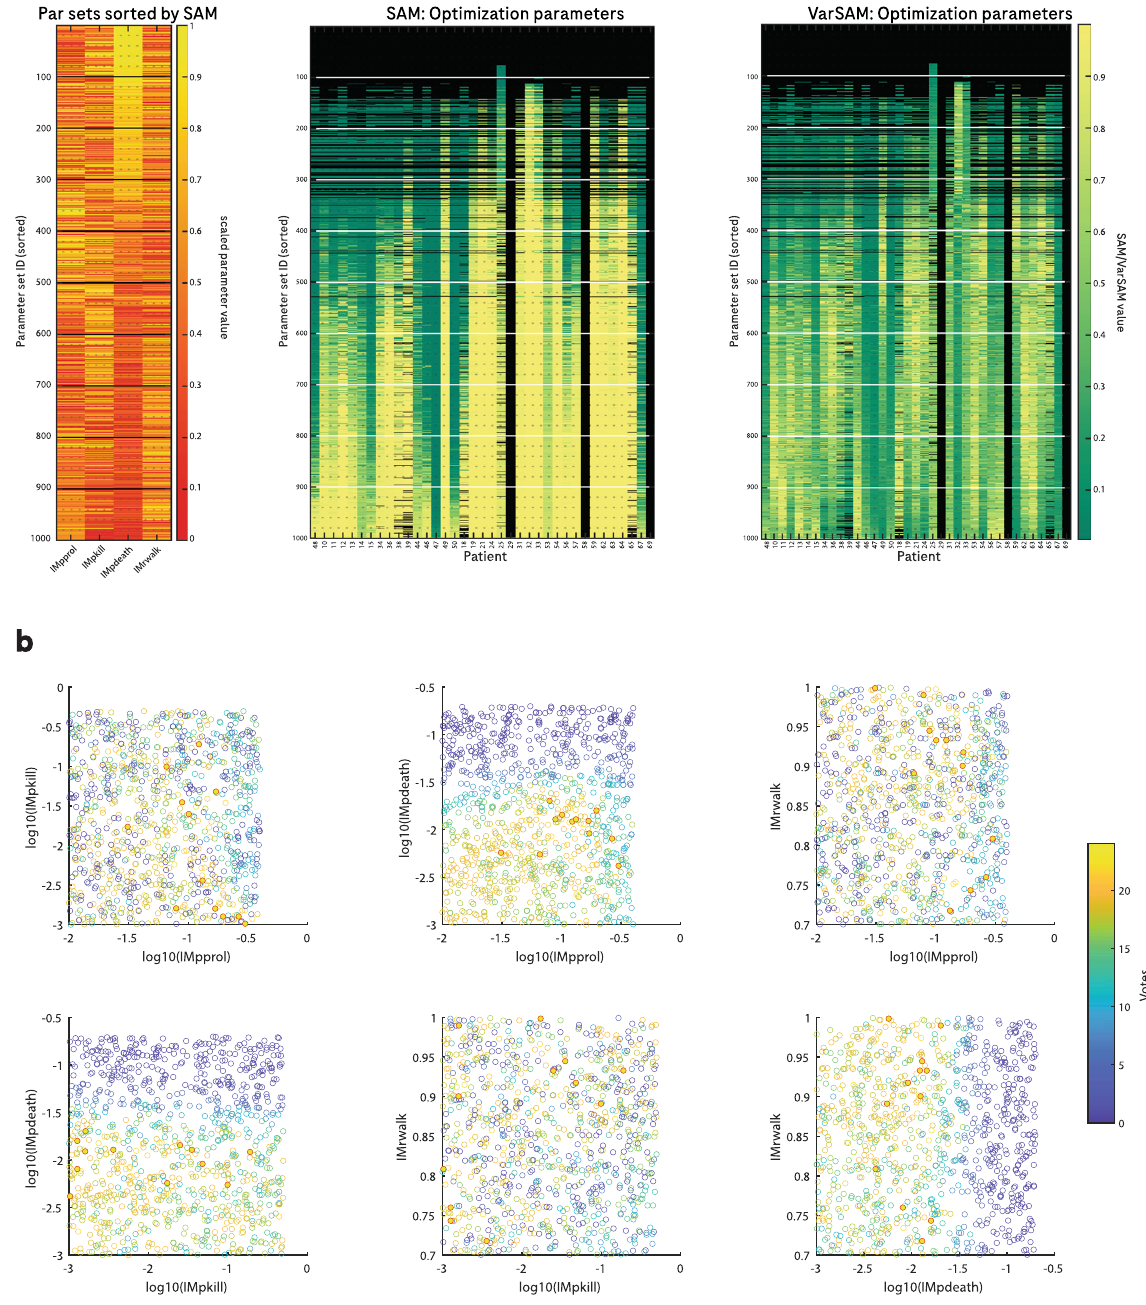
Fig. 4 Model optimisation. a Heatmaps summarising the optimisation results. Left: normalised parameter values sorted by SAM score. Middle: SAM score for each parameter set for each patient in the training set where green indicates a low SAM (low agreement between simulated and observed samples) and yellow indicates high agreement. Black indicates that there were too few CD8 cells (<10) to make a meaningful evaluation via the SAM. Rows are sorted by the SAM score across all patients. Right: VarSAM values sorted by the SAM score across all patients. Green indicates that simulated biopsies did not capture the variability in the fi rst 15 distance units of the observed RDFs, whereas yellow indicates a good representation of the observed variability. b Two-dimensional projections in parameter space of the SAM votes for each sampled parameter set, where one vote corresponds to one patient in the training set for which the SAM was above a threshold of 0.7 and the VarSAM was above a threshold of 0.3. Red circles with a red rim indicate parameter sets that were accepted according to the SAM since they had more than 22